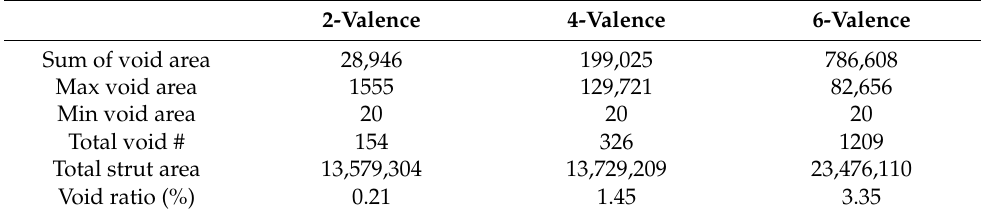
Table 6. Void properties. All areas are in µ m 2